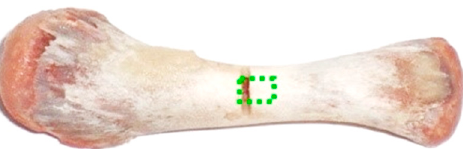
Figure 2. Extracted chicken humerus prepared for the reference OCT measurement. The green rectangle indicates the scanned region.